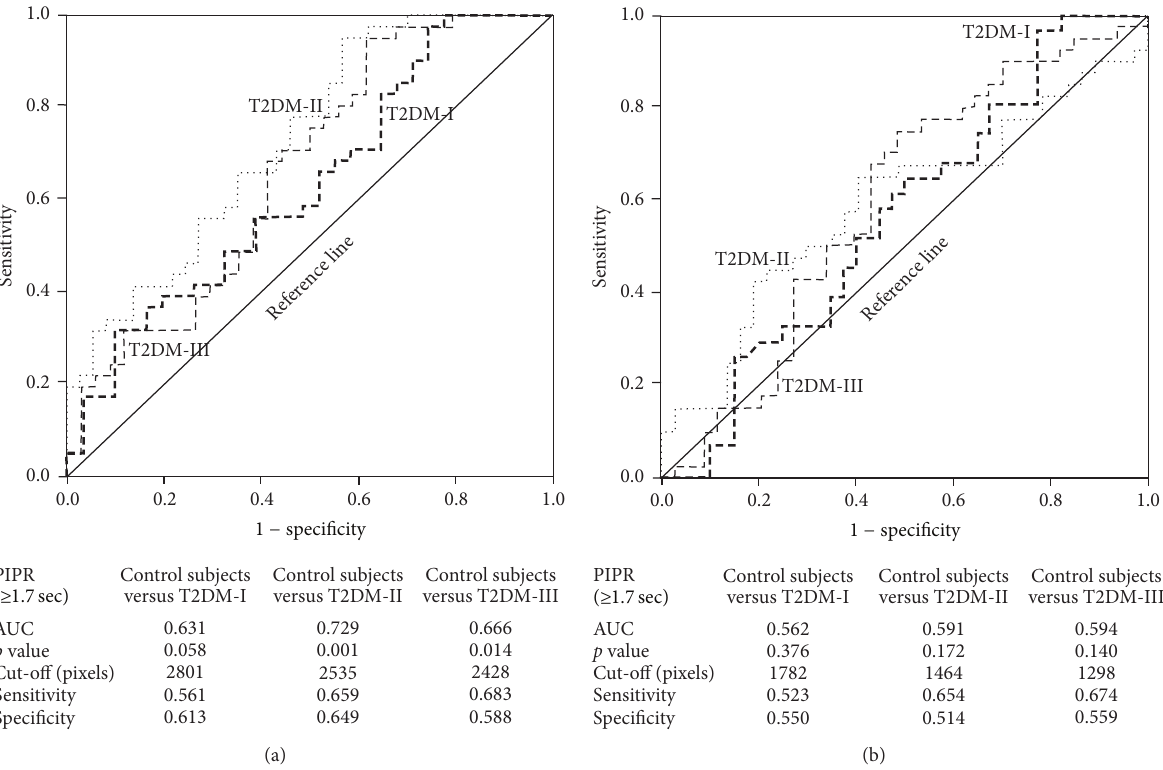
Figure 4: The receiver operating characteristic (ROC) curve analysis of postillumination pupillary response (PIPR) after the offset of blue (a) and red (b) light at ≥ 1.7–3.0 sec between the control subjects and diabetic subgroups stratified by the severity of neuropathy { I; without neuropathy ( ------ ), II; asymptomatic neuropathy ( ⋅⋅⋅⋅⋅⋅⋅⋅ ), and III; symptomatic but without diabetic autonomic neuropathy (---) }